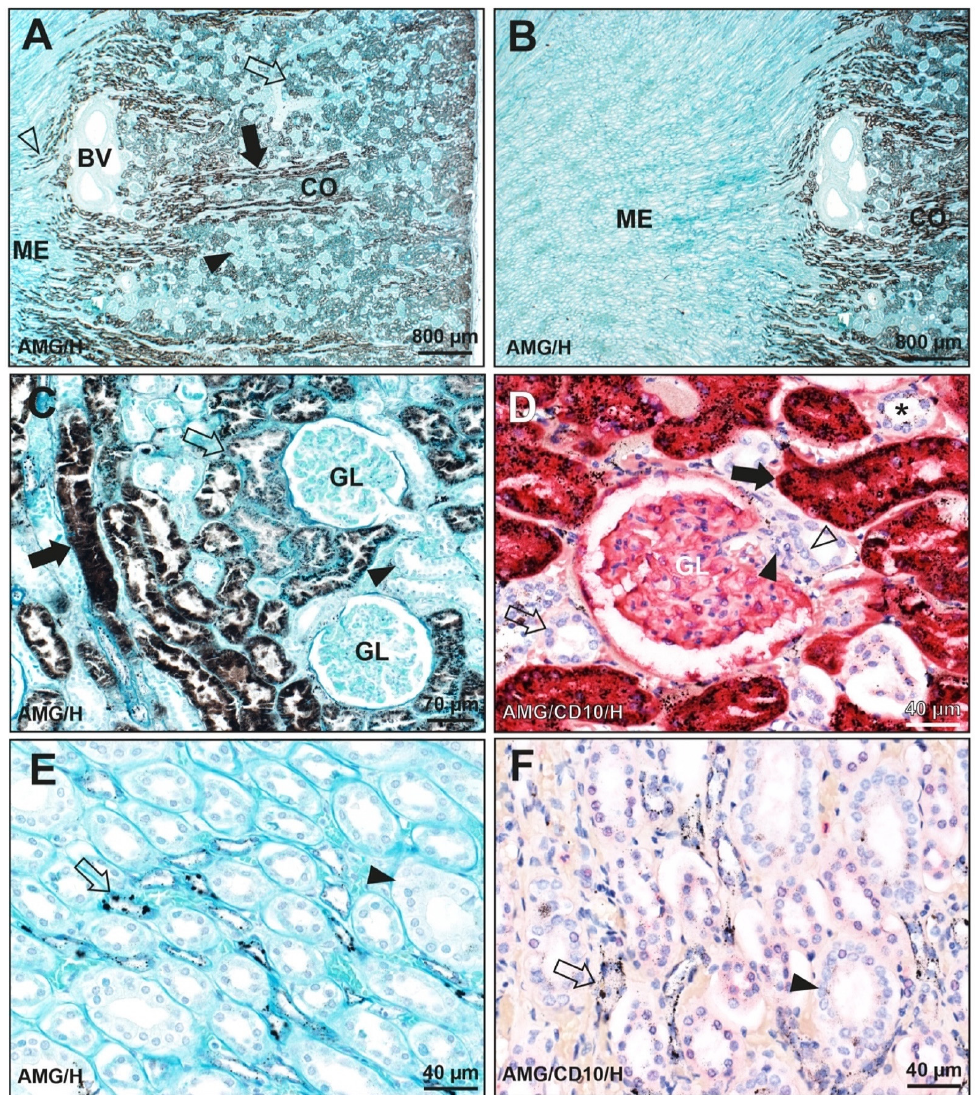
Figure 1. Autometallography of the kidney of a man who had injected himself with metallic mercury (K24). ( A ) Black- staining mercury is seen in the renal cortex (CO) in cells of both the straight (filled arrow) and convoluted (open arrow) proximal tubules, with more mercury in straight tubules. The pale cortical regions (closed arrowhead) contain glomeruli and distal tubules. Some mercury-containing proximal straight tubules (open arrowhead) extend a short distance into the pale-staining medulla (ME). Large pale-staining blood vessels (BV) are present near the cortico-medullary junction. ( B ) A microscopic field to the left of the image in A shows the difference between the dark-staining mercury in the renal cortex (CO) and the pale medulla (ME). ( C ) Mercury is seen in cells of the proximal straight tubules (filled arrow), with less in the proximal convoluted tubules (open arrow). No mercury is seen in two glomeruli (GL) or in distal tubules (arrowhead). ( D ) Red CD10 immunostaining is seen in proximal tubule cells containing black mercury grains (filled arrow). In CD10-negative distal tubules, either no (open arrow) or minimal (asterisk) mercury staining is seen. No mercury is seen in the macula densa (open arrowhead) or Lacis cells (filled arrowhead) of the juxtaglomerular apparatus or in a glomerulus (GL) whose podocytes stain lightly with CD10. ( E ) Cells in Henle thin loops in the medulla contain black mercury granules of varying size (arrow). Collecting tubules (arrowhead) do not contain mercury. ( F ) Cells in Henle thin loops (not CD10-immunostained) in the medulla contain black mercury granules of varying size (arrow). Collecting tubules that stain with CD10 (arrowhead) do not contain mercury. Light brown/yellow staining is from red blood cells in capillaries. AMG/H autometallography/hematoxylin, AMG/CD10/H autometallography/CD10 immunostaining/hematoxylin, K identity number (see Table